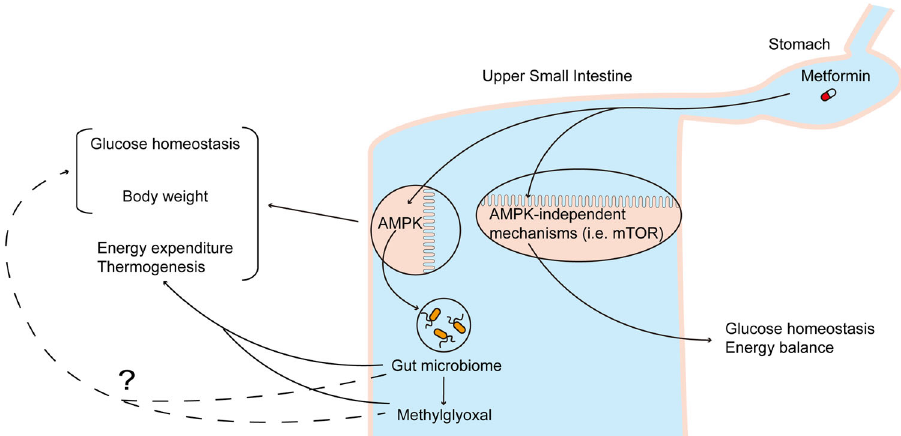
Fig. 1 Metabolic regulation by metformin through intestinal AMPK-dependent and -independent pathways. With the use of high-fat fed intestinal AMPK α 1 knockout mice, Zhang et al. demonstrated that intestinal AMPK α 1 de fi ciency per se altered energy expenditure and brown fat thermogenesis through changes in the gut microbiome and potentially methylglyoxal, impaired glucose tolerance and induced weight gain. Intestinal AMPK α 1 de fi ciency also impaired the ability of metformin to increase glucose tolerance and lower body weight. In parallel, metformin alters intestinal AMPK-independent pathways (i.e., mTOR) to regulate glucose homeostasis. We propose metformin activates small intestinal AMPK-dependent and – independent pathways to regulate glucose homeostasis and energy balance in diabetes and